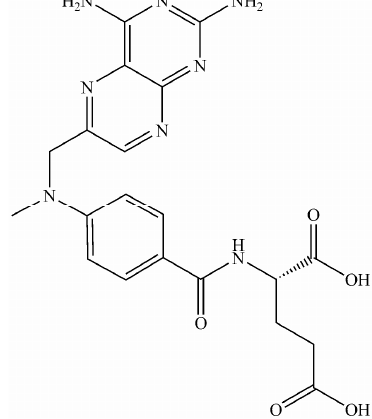
Figure 1. Chemical structure of